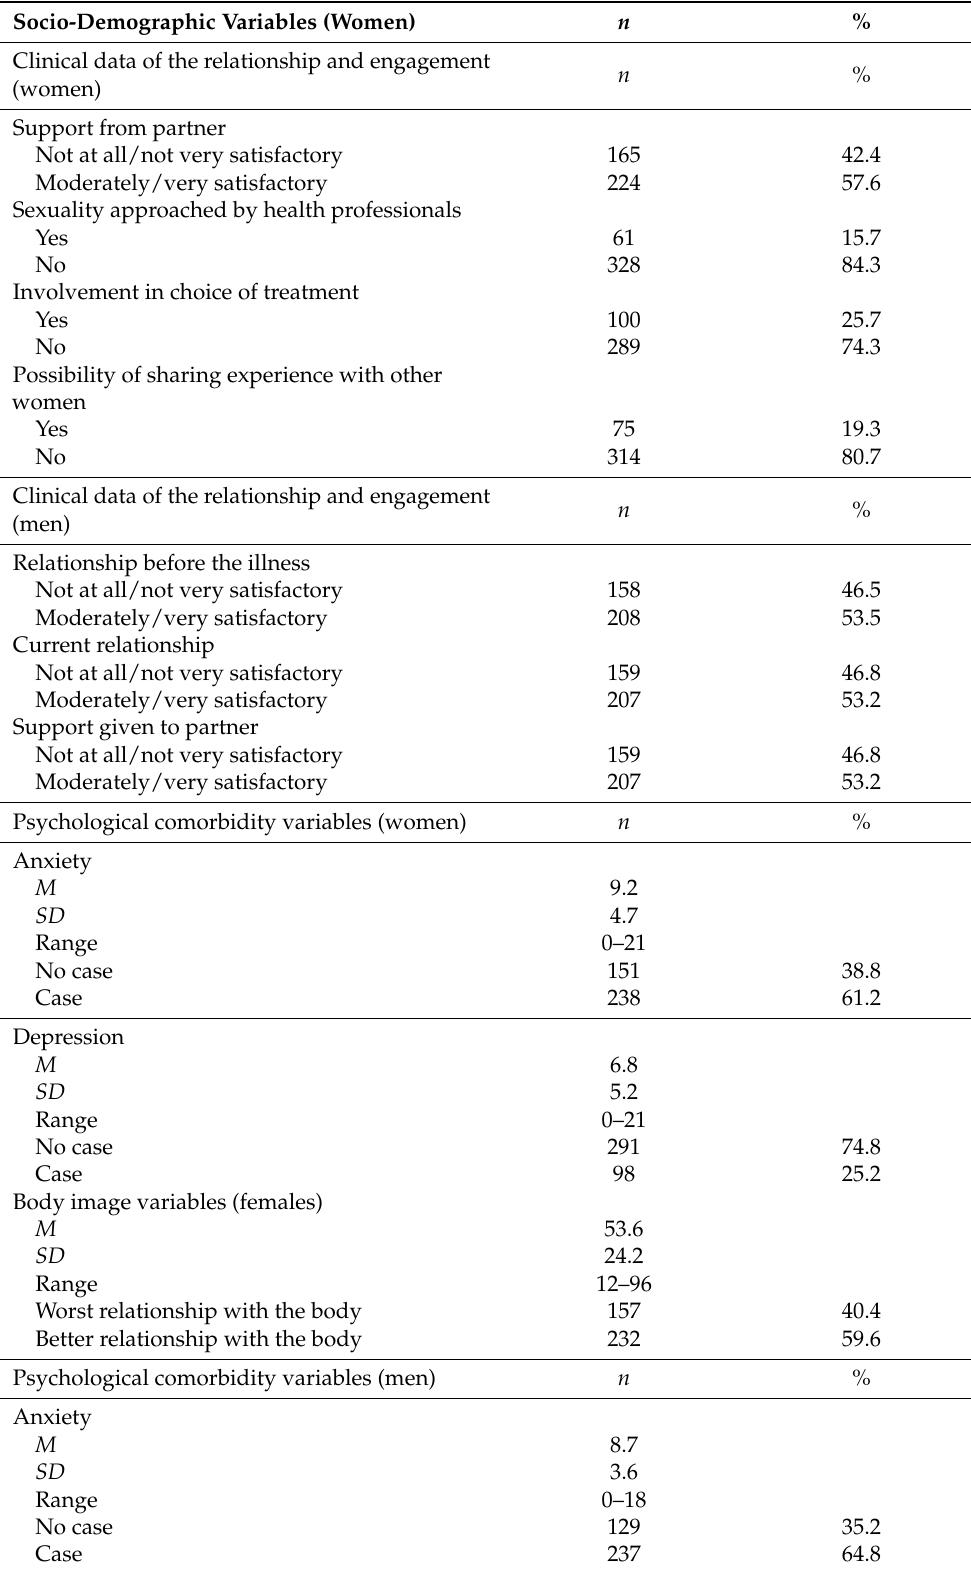
Table 1. Cont . Socio-Demographic Variables